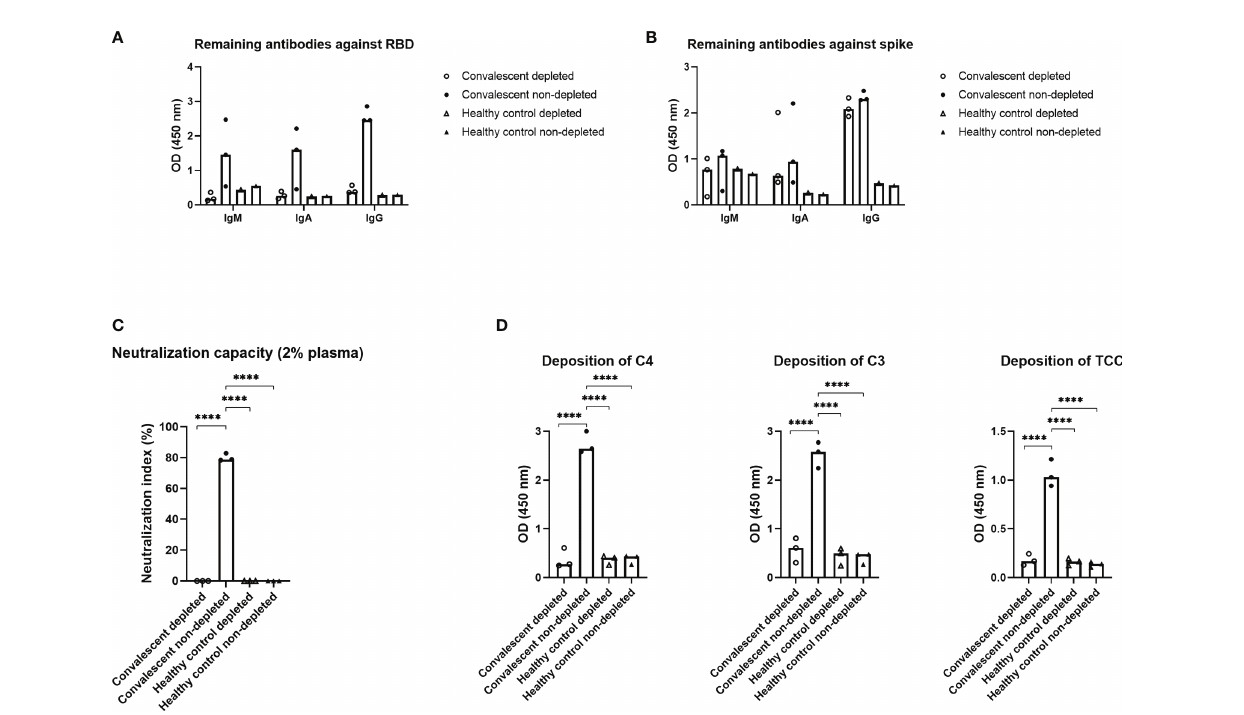
FIGURE 4 | Effect of depletion of antibodies against RBD. Plasma from three recovered convalescent individuals and healthy control individuals was depleted for anti-RBD antibodies and subjected to the following assays; (A) an RBD speci fi c sandwich ELISA, (B) a spike speci fi c sandwich ELISA, (C) a neutralizing assay and (D) a complement deposition assay, with spike as the antigen. The RBD and spike speci fi c assays utilized plates coated with RBD or spike (1 µg/ml) and HRP- conjugated polyclonal rabbit antibodies against human IgM, IgA, or IgG (1 µg/ml) for detection. A p value < 0.05 was considered signi fi cant. ****p < 0.0001 using an ordinary one-way-ANOVA with Holm-S ̌ ı ́ da ́ k ’ s multiple comparisons test. Data are represented as mean values of two independent